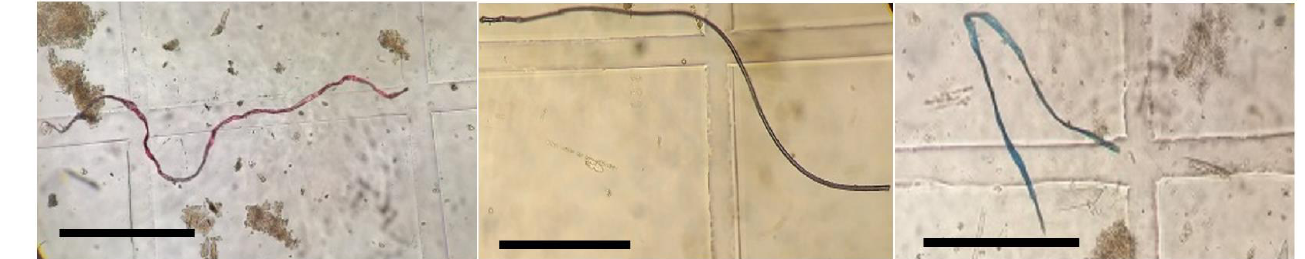
Figure 3. Examples of anthropogenic debris observed in the stomachs of fish. Scale bar 1 mm. Table 4. Abundance of ingested anthropogenic debris by number and colour in the 12 marine fish species of non-empty-stomach fish. Parentheses enclose the number of fish with ingested debris.